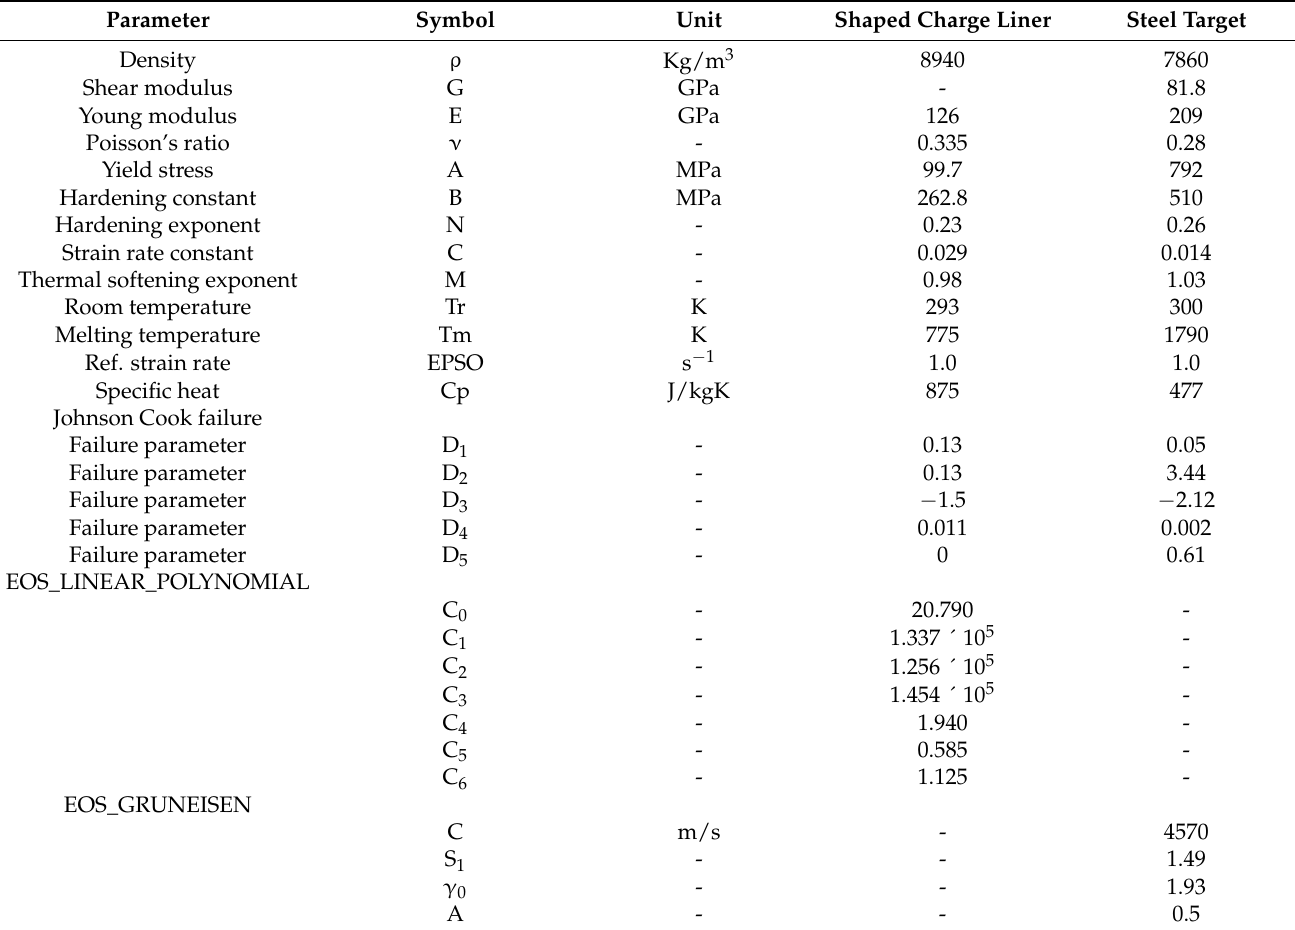
Table 1. Material data for cumulative insert and steel target